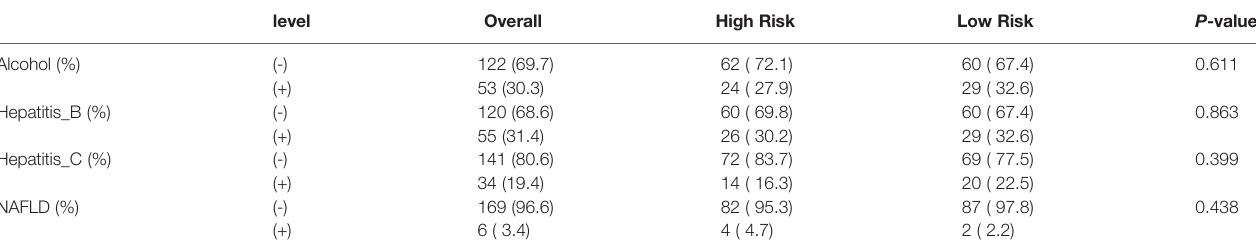
TABLE 3 | Proportion of each causative agents in training